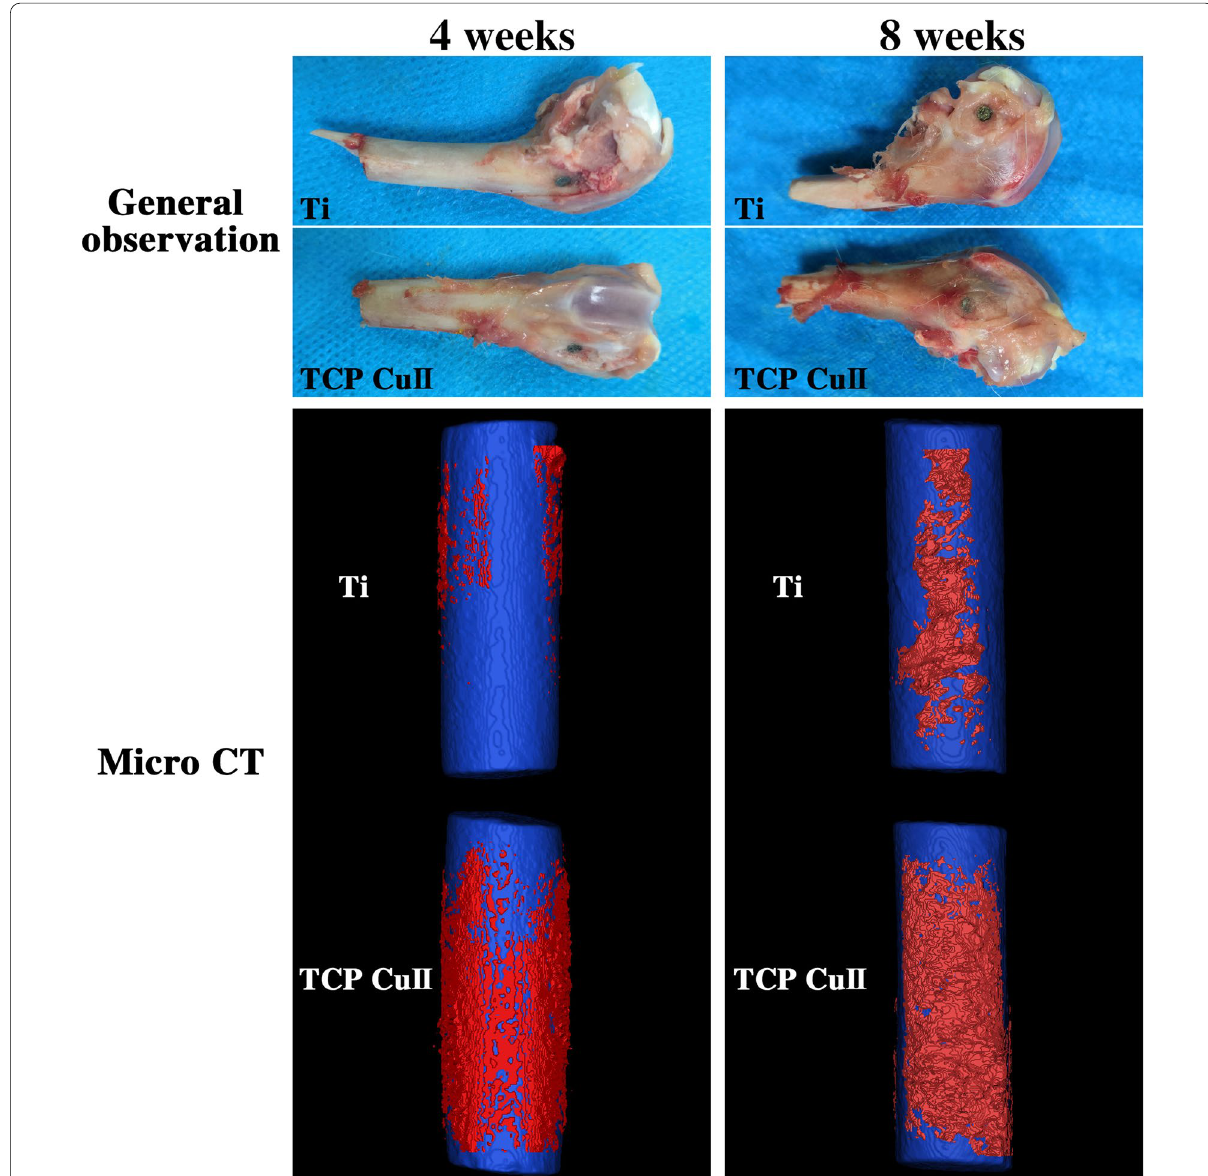
Fig. 10 Gross observation and micro‑CT reconstruction of the femoral condyle were observed at 4 and 8 weeks after